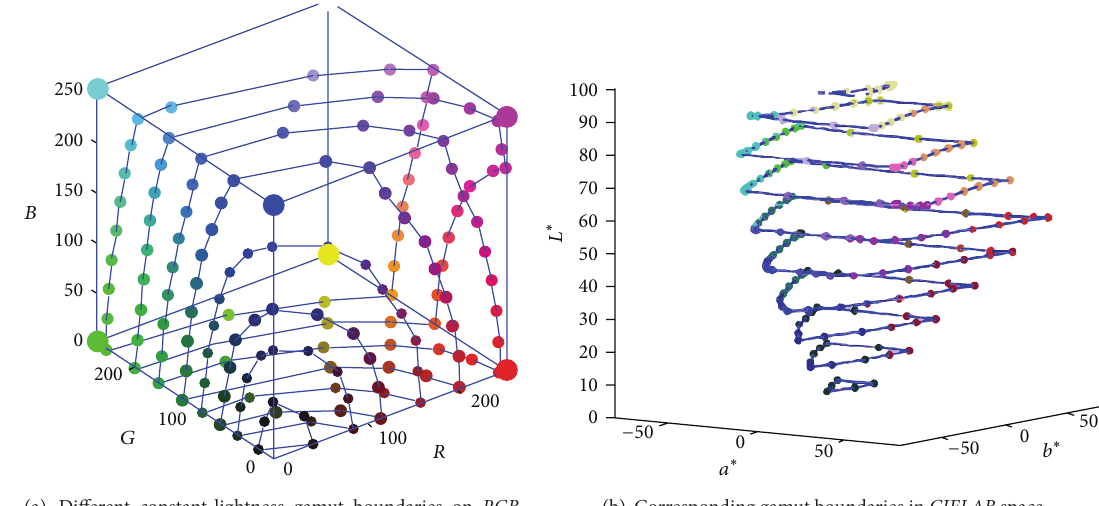
Figure 7: The 2D gamut boundary of different lightness.